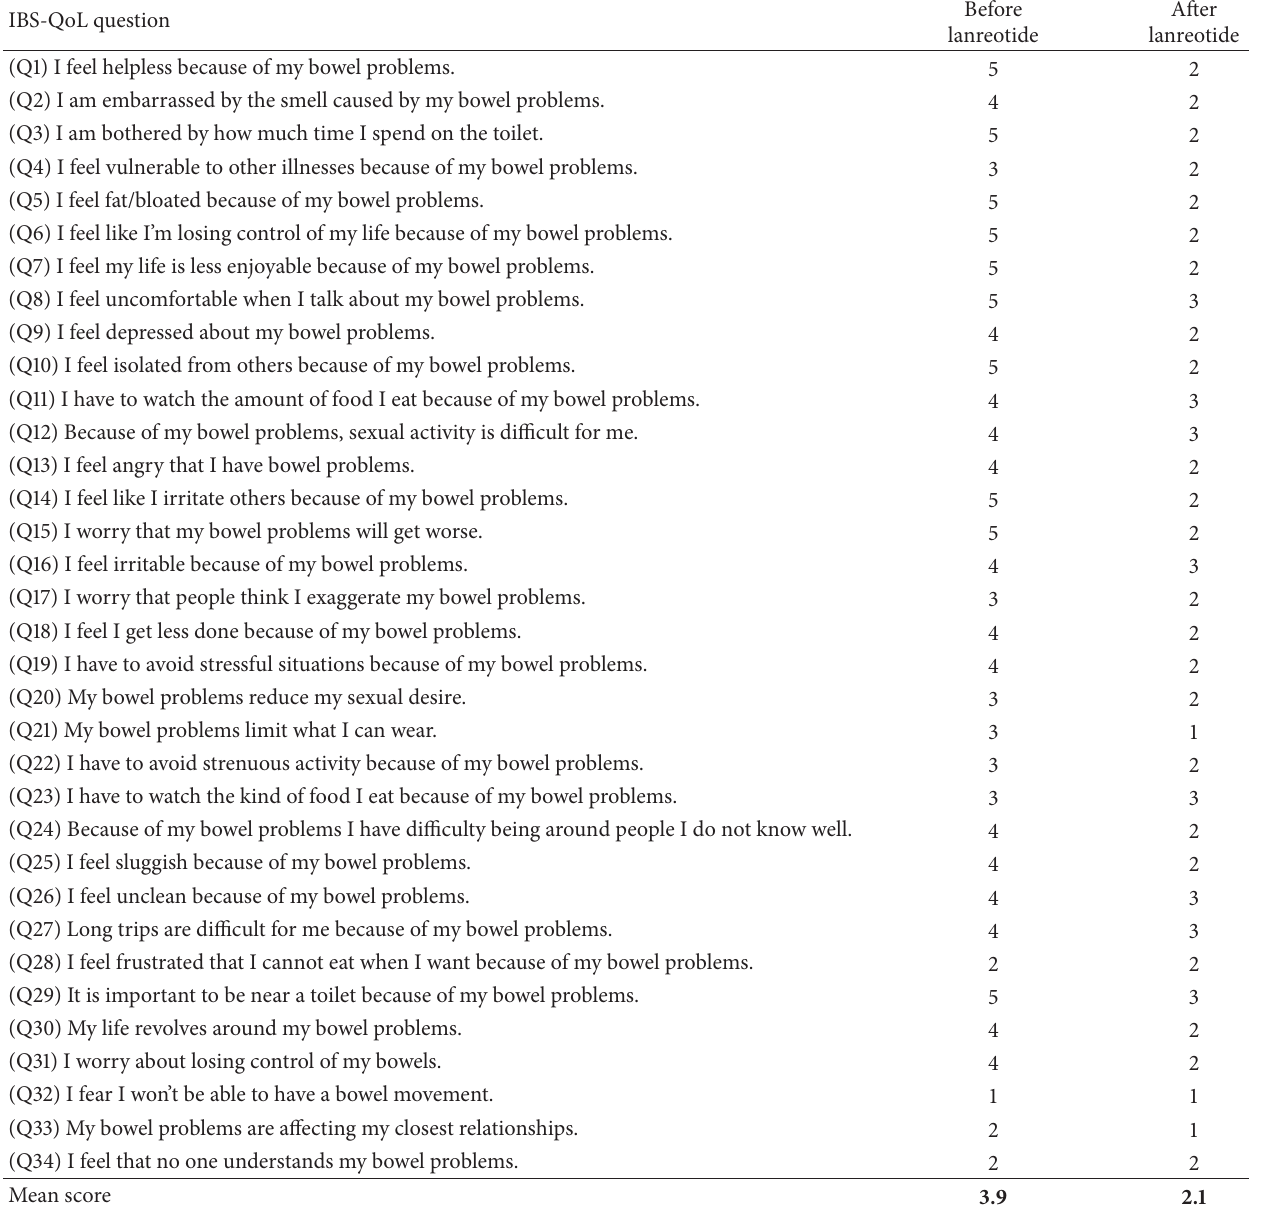
Table 1: Irritable Bowel Syndrome Quality of Life questionnaire score before and after the lanreotide Autogel treatment. IBS-QoL question